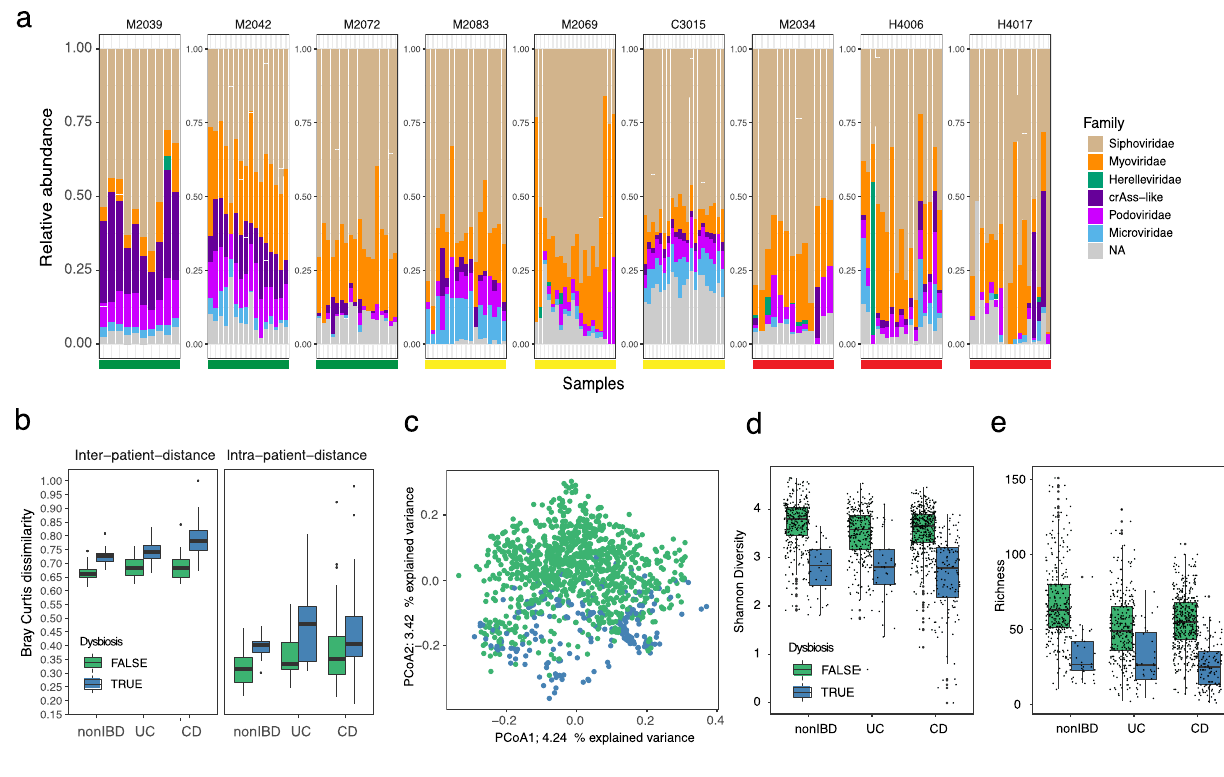
Fig. 4 The metagenomics estimated virome is personal and highly stable in healthy controls. a Longitudinal virome compositions for three nonIBD (green bar), three UC (yellow bar) and three CD (red bar) diagnosed subjects. Each panel represents a subject where the virome composition was organised according to the total relative abundance according to the taxonomic viral family, where ‘ NA ’ populations are coloured grey. b Dissimilarity boxplots based on Bray – Curtis distance (BC) function between samples from different subjects ( fi rst panel inter-patient-distance) and between samples from the same subject (second panel intra-patient-distance). The BC distances are shown for samples from nonIBD ( n = 326), UC ( n = 323) and CD ( n = 573) diagnosed subjects. Furthermore, BC distances are coloured according to dysbiosis (blue, UC = 39 samples, CD = 133 samples, nonIBD = 38 samples) or not (green, UC = 284 samples, CD = 425 samples, nonIBD = 286 samples). c Principal component analysis (PCoA) of Bray – Curtis distance matrix calculated from the viral abundance matrix in HMP2. Each point is coloured according to diagnosed dysbiosis as in ( b ). d Shannon-diversity estimates of metagenomics derived viral populations and coloured according to dysbiosis as in ( b ). e Per sample viral population richness based on the number of viral populations detected (abundance >0) in the samples. Coloured according to dysbiosis as in ( b ). nonIBD: healthy control, UC ulcerative colitis, CD Crohn ’ s